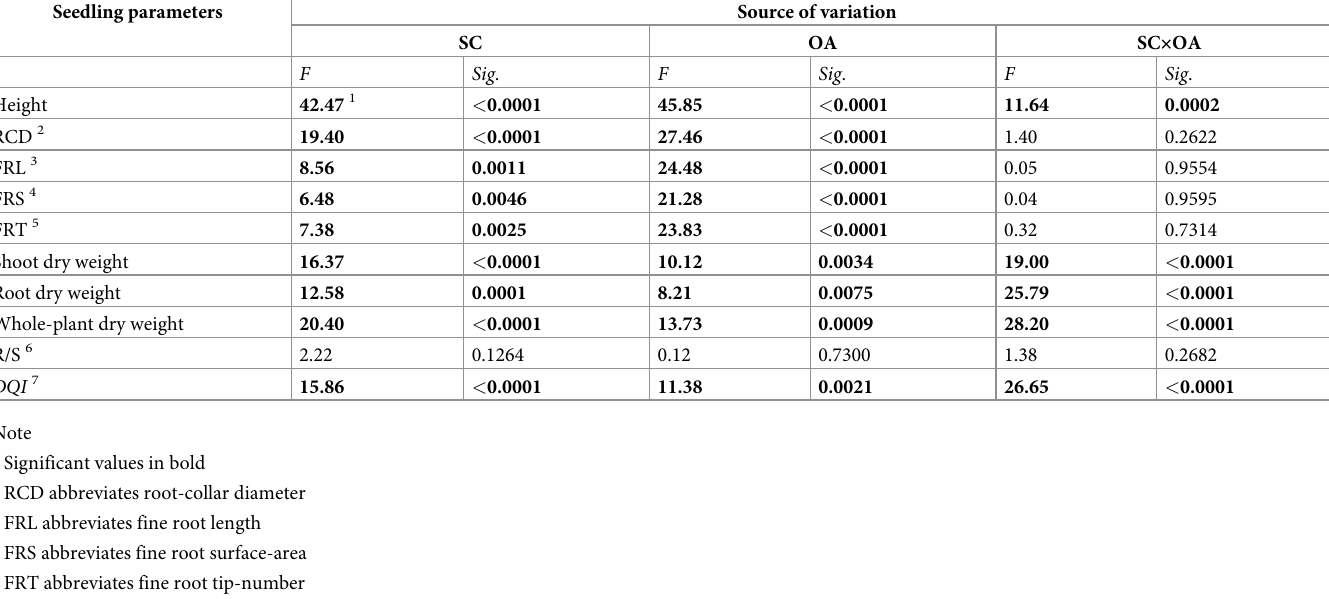
Table 2. Analysis of variance (ANOVA) of spectral condition (SC), oligosaccharide spray (OA), and their combination (SC × OA) on morphology, dry weight bio- mass, and quality assessment in Podocarpus macrophyllus seedlings.